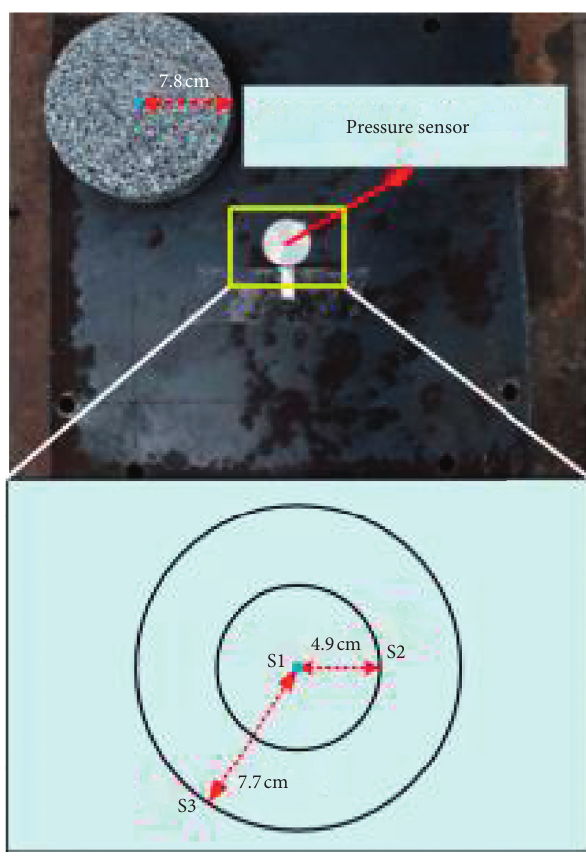
Figure 5: Sensor settings.